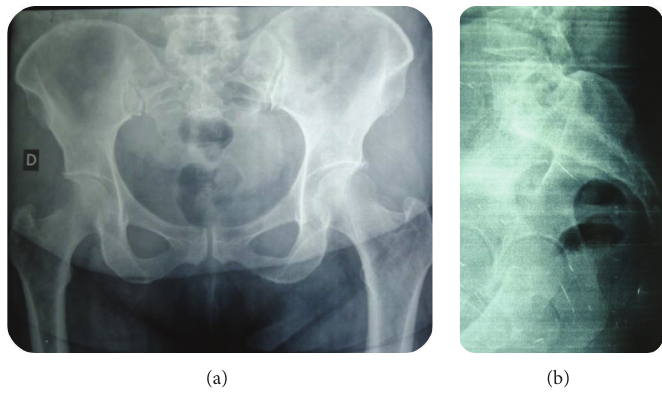
Figure 5: Follow-up AP and oblique X-rays of pelvis at 3 years showing no evidence of